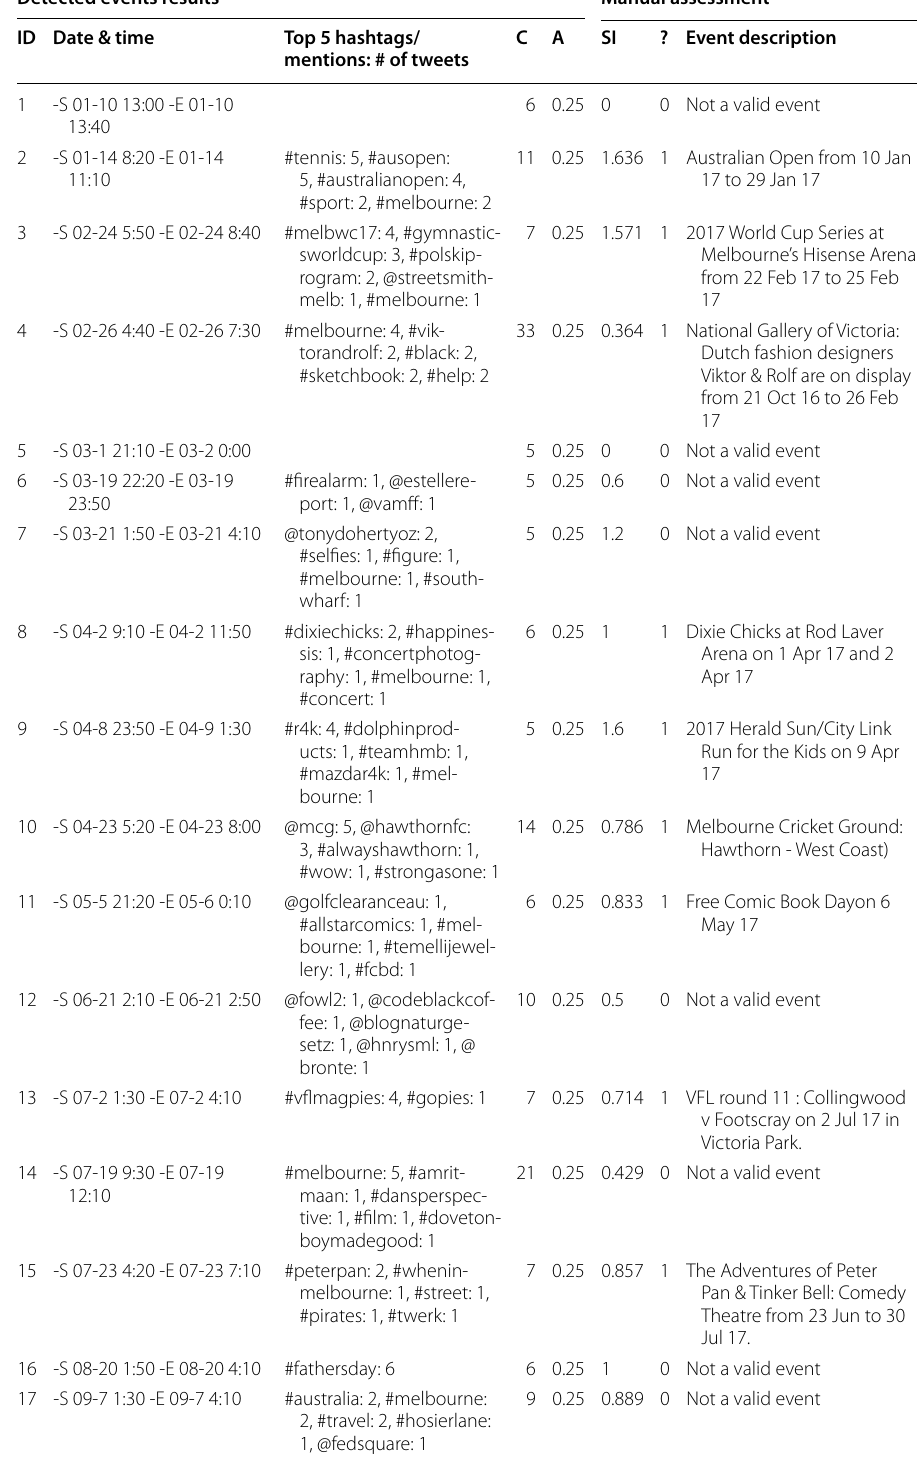
Table 10 Precision results for clustering based event detection: Melbourne detected events in 2017 using geotagged tweets (random selection of 20 events) Detected events results Manual